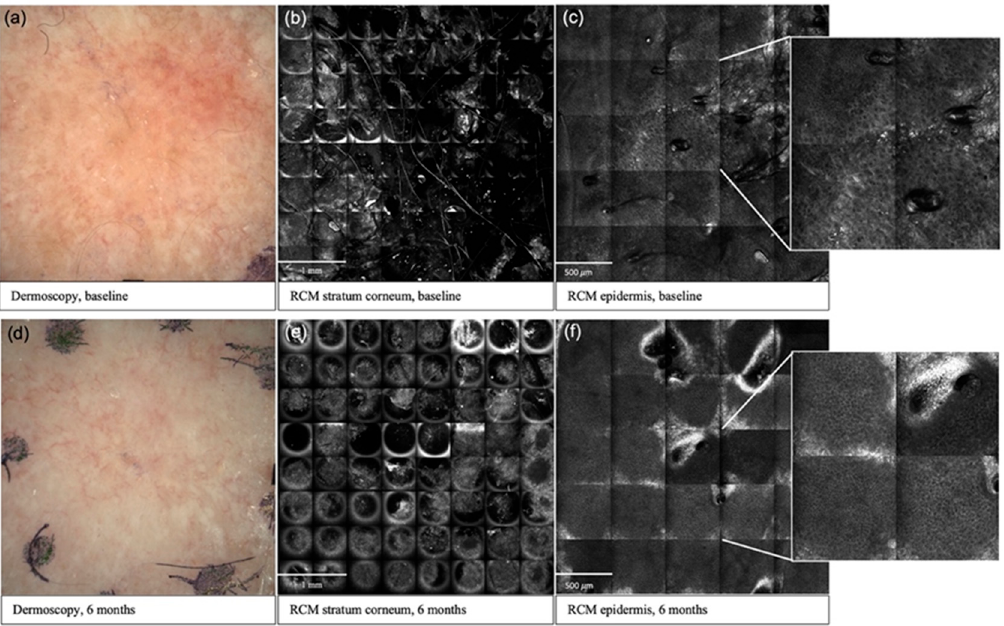
Figure 1. Clinical and reflectance confocal microscopy images over time in an AK lesion. Baseline ( a ) and 6 months ( d ) dermoscopic assessment of a G1 AK in the cryotherapy group; improvement in stratum corneum disruption from baseline ( b ) to 6 months ( e ) post-cryotherapy; improvement in atypical honeycomb pattern from baseline ( c ) to 6 months ( f ) post-cryotherapy.